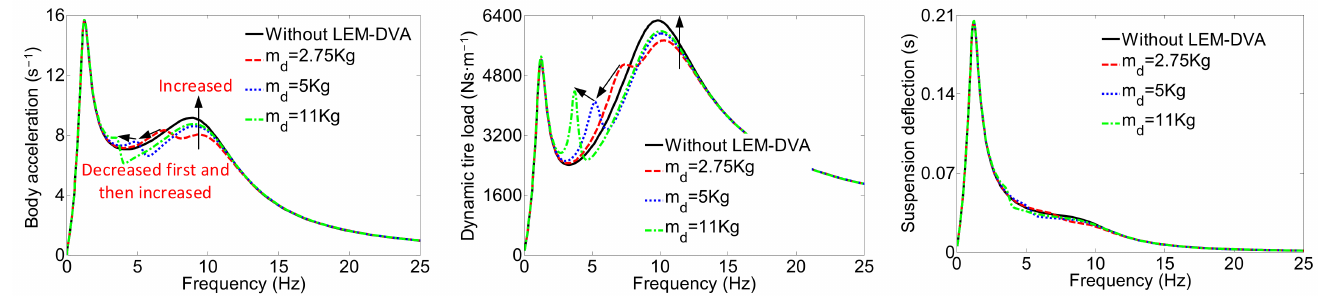
Figure 7. Sensitivity analysis on m d